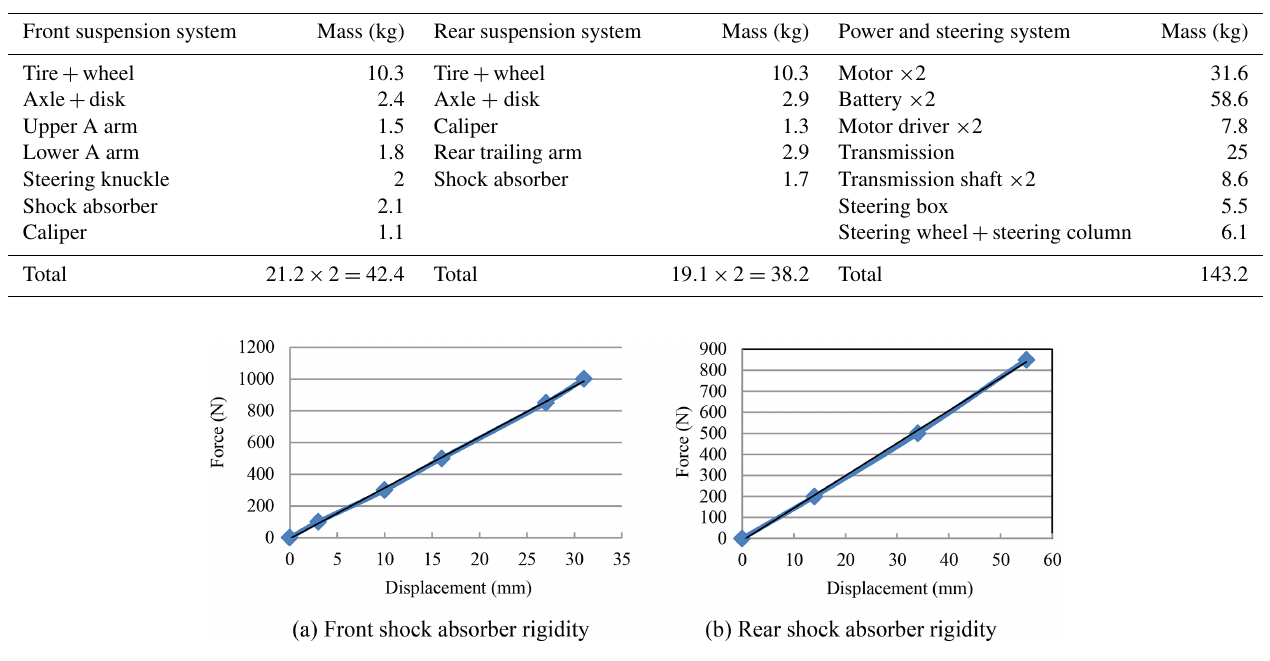
Table 1. Measured mass values of main EV system components.